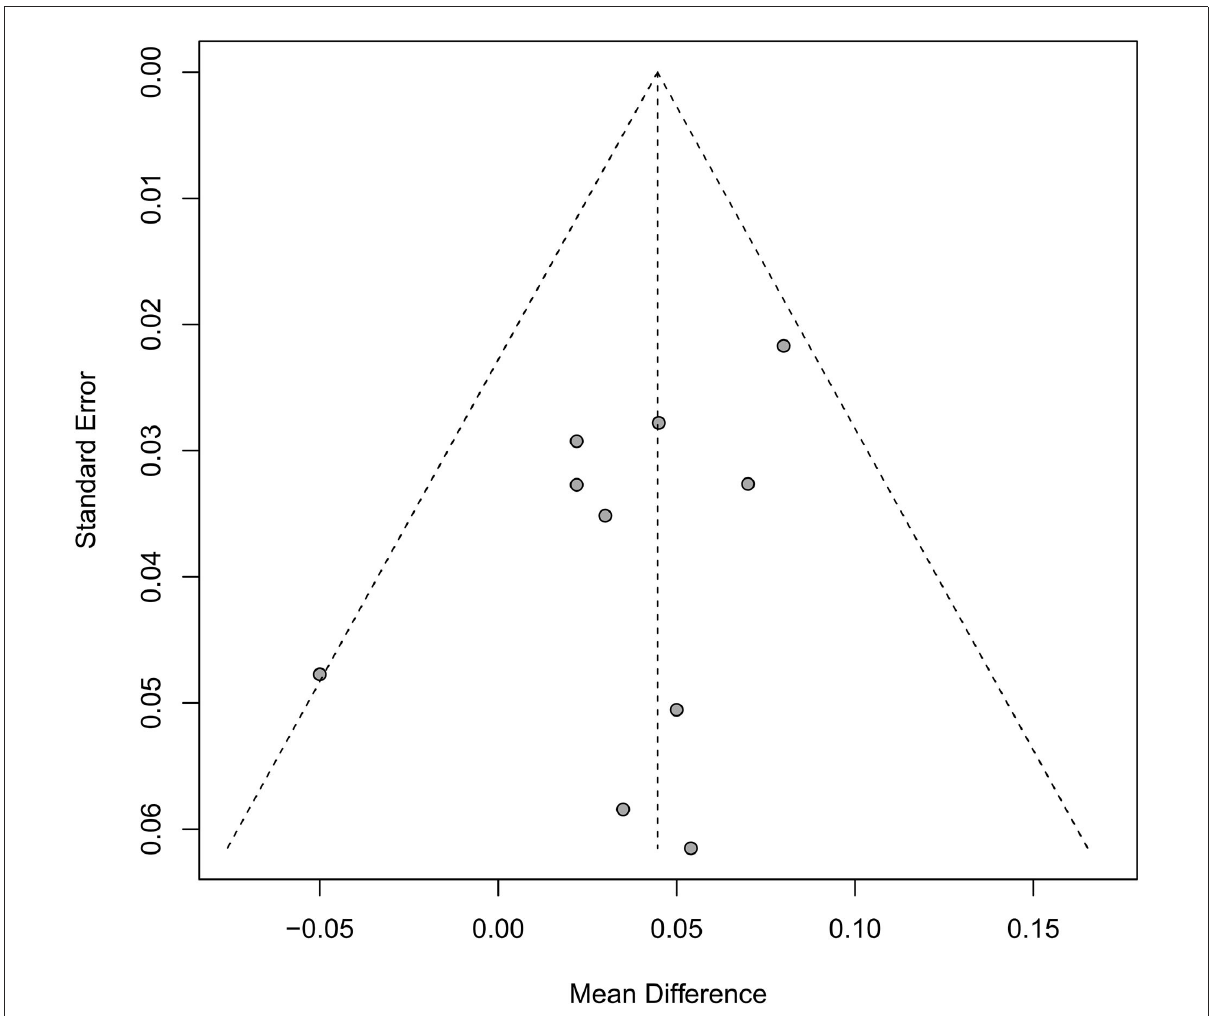
FIGURE6 The funnel plot of BMD of lumbar spine of Tai Chi vs.